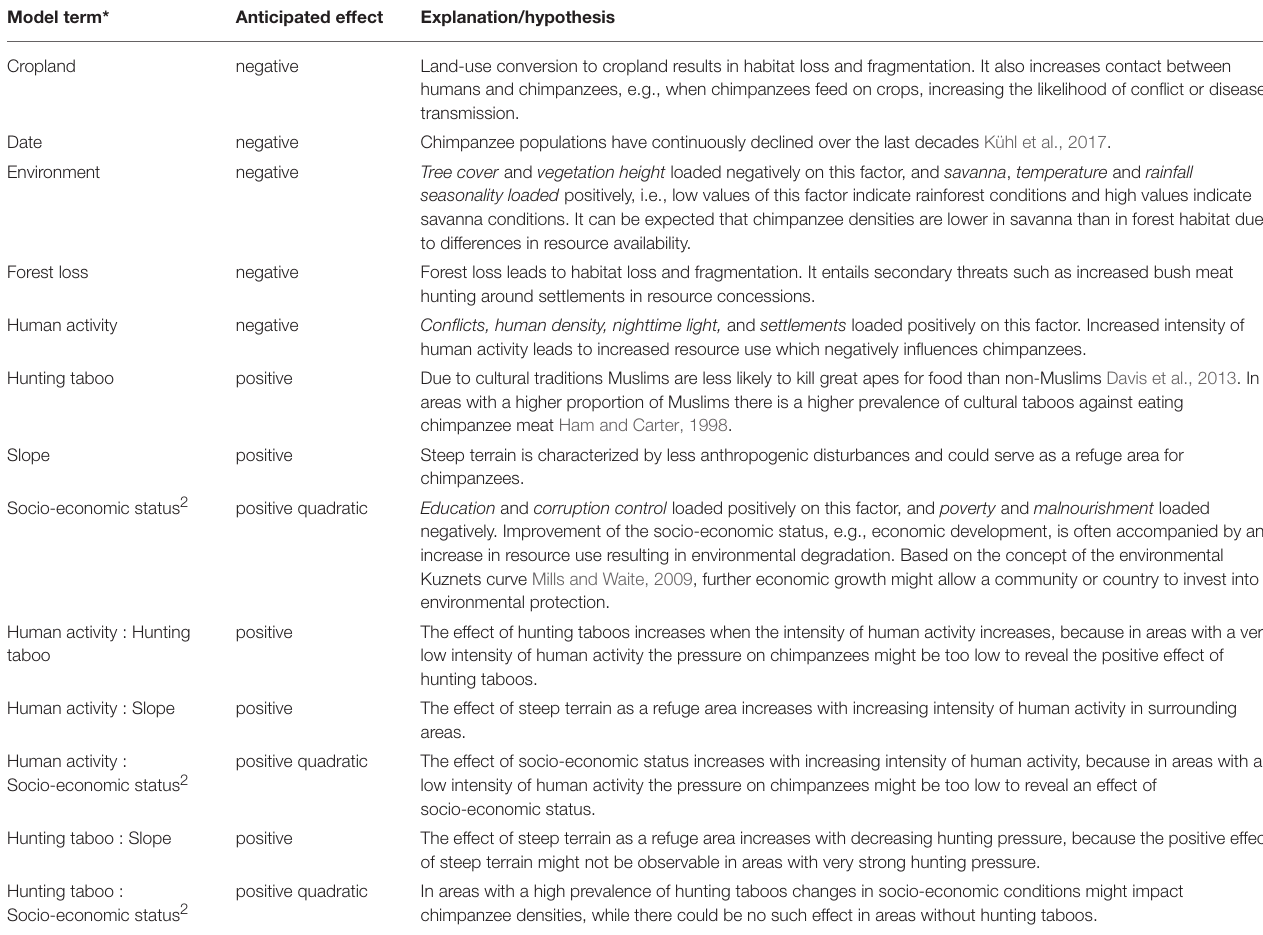
TABLE 2 | Anticipated effects of model terms included as test predictors into the